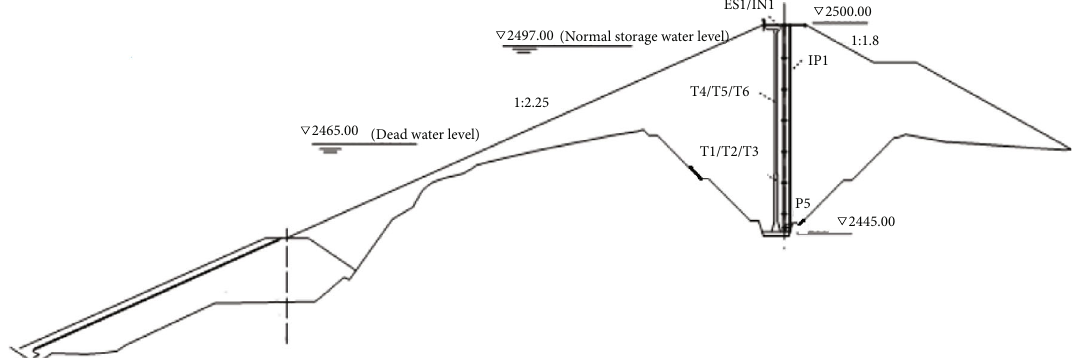
Figure 3: Distribution map of seepage monitoring instrument in the cross section 0 +100.